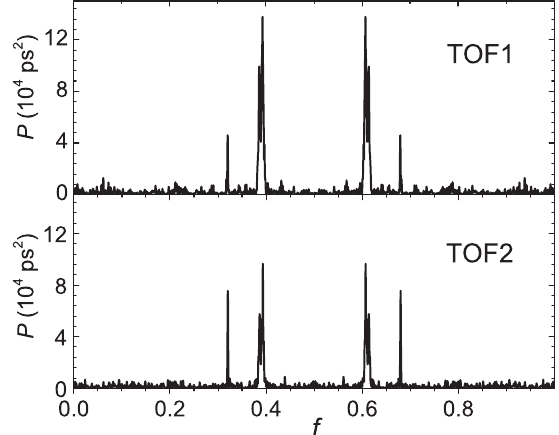
FIG. 7. Periodogram extracted from the fit residuals in Fig.